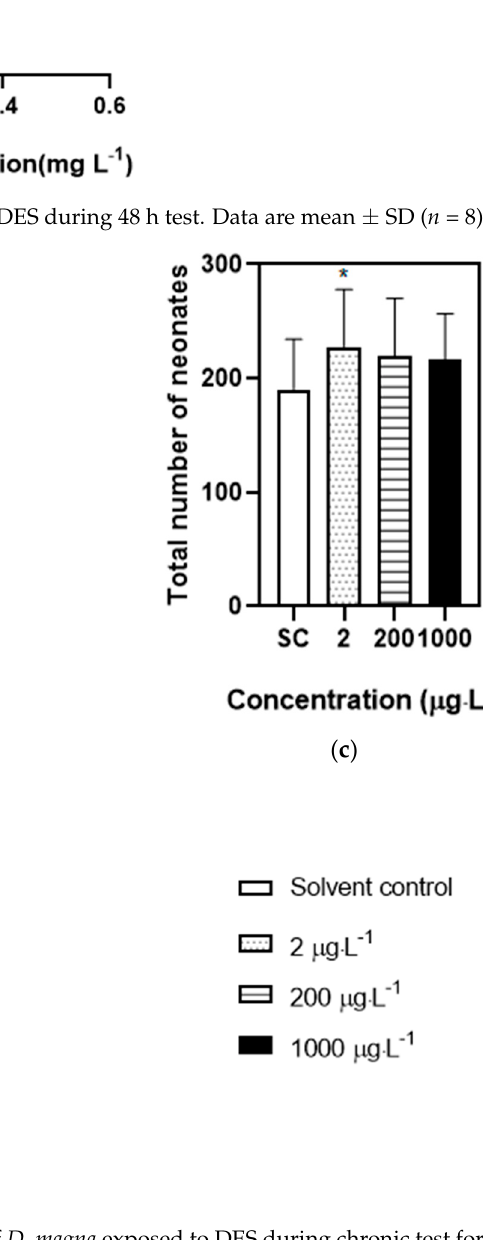
Figure 2. Physiological parameters of D. magna exposed to DES during chronic test for 21 d. ( a ) The first spawning time of D. magna ; ( b ) the body length of D. magna at 7, 14, 21 d; ( c ) the total number of neonates of D. magna . “*” suggesting the parameters are statistically different between treatment groups and solvent control groups ( p < 0.05 and n = 20).